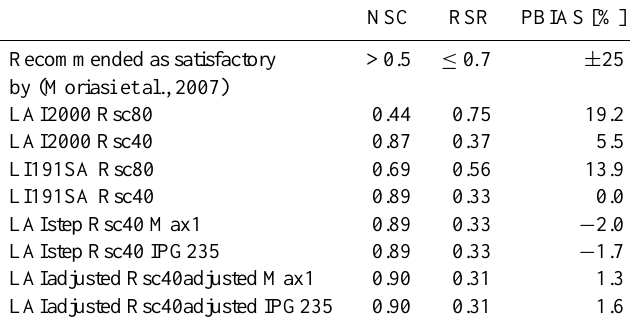
Table 4. Statistical parameters for model evaluation in terms of the accuracy of simulated data compared to measured values. Nash–Sutcliffe efficiency criterion (NSC), percent bias (PBIAS), and ratio of the root mean square error to the standard deviation of measured data (RSR) are calculated from plant available soil water till 1m soil depth as derived from model simulations and soil water content measurements for the period from April to December 2013, to cover the period of most variability. NSC